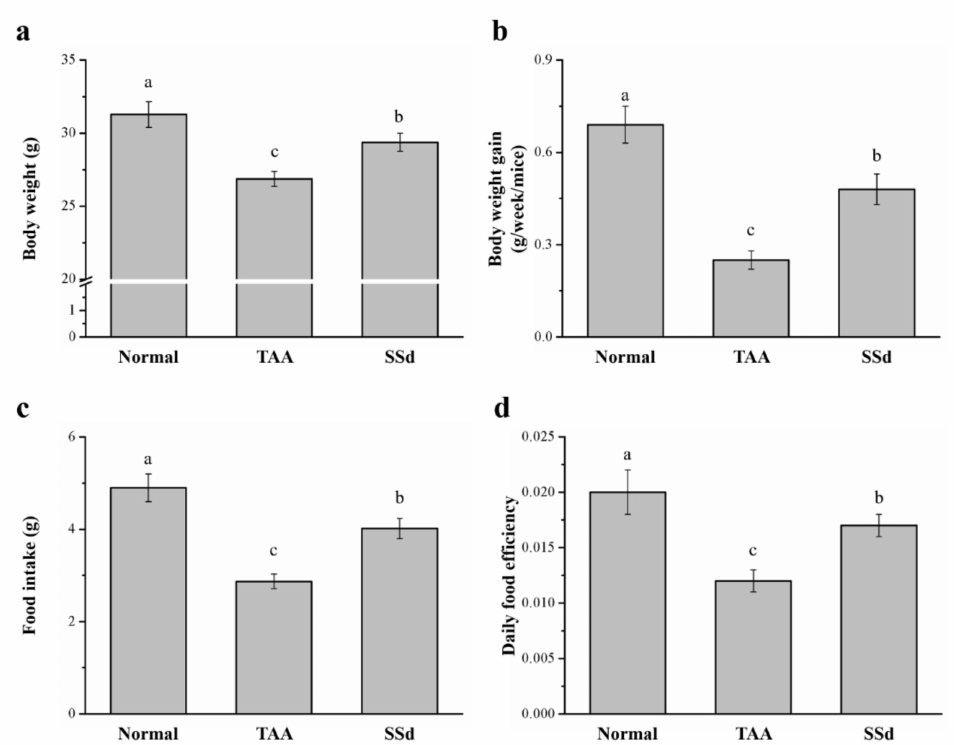
Figure 1. Changes in ( a ) body weight, ( b ) weekly body weight gain, ( c ) food intake, and ( d ) daily food efficiency in the control, TAA, and SSd groups over 8 weeks. All data are reported as means ± SD (n = 8). a–c Data with different letters above the columns were significantly different on one-way ANOVA, and Duncan’s test at p < 0.05 was used to compare the means of the three groups. TAA, thioacetamide; SSd, saikosaponin-d; SD, standard deviation; ANOVA, analysis of